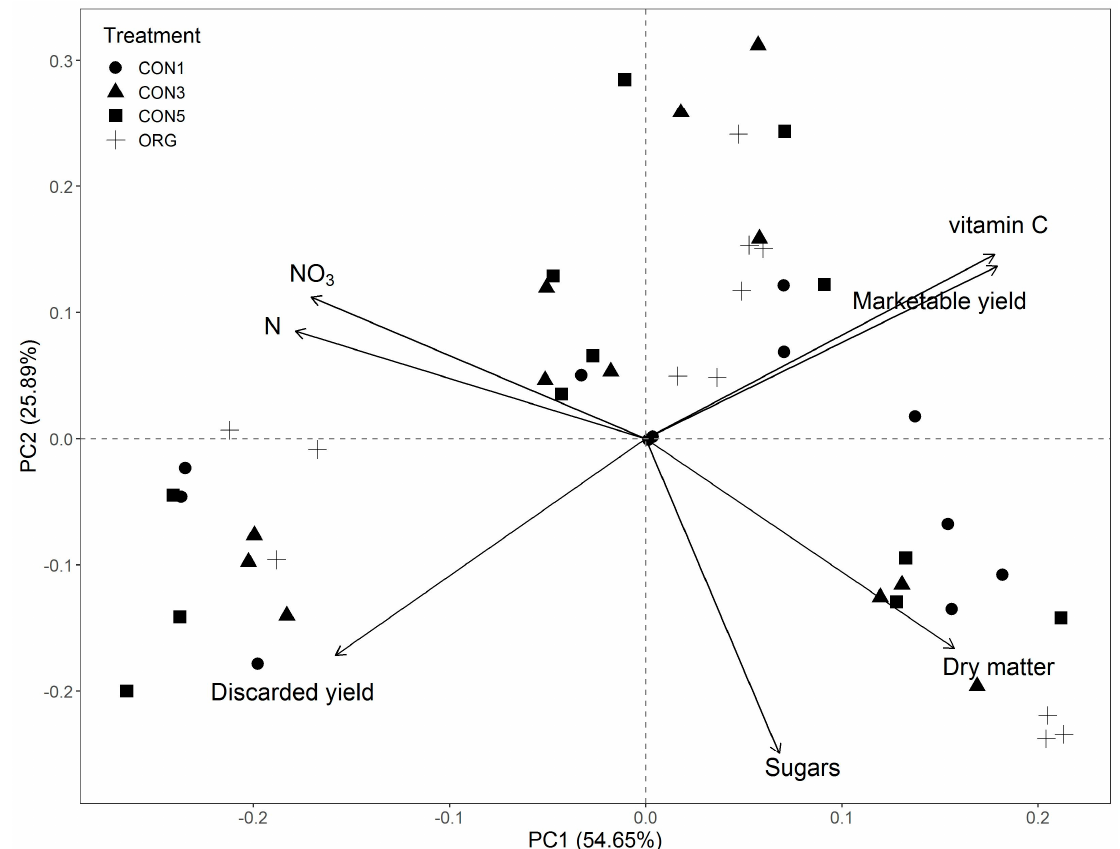
Figure 1. Biplot of principal component analysis by treatments. Vectors indicate the direction of increase of the carrot yield and quality parameters respective to the first two principal components; symbols distinguished by treatments mark the location of single samples in the PC1-PC2-plane.